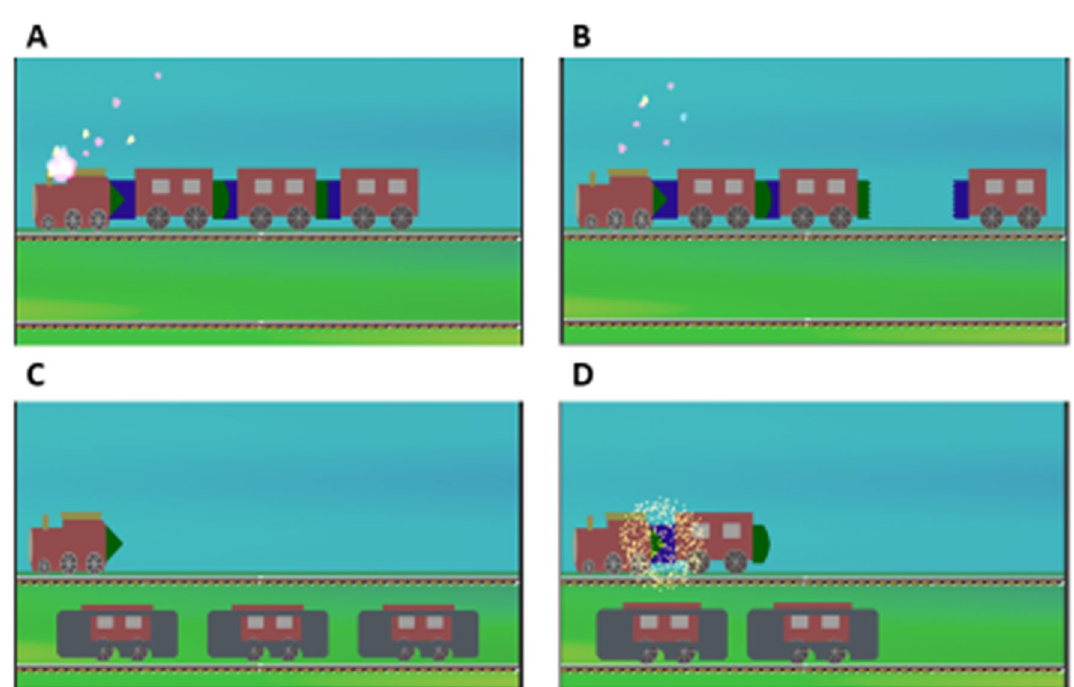
Figure 2. Train game gameplay. ( A ) A train moves into the scene with smoke animation and sound. ( B ) Each wagon detaches from the train and moves to a random position on the rail track below. ( C ) After some delay, the shapes at the ends of the wagons are hidden by a cover. The player is then prompted to select the wagon that has the shape complementary to the last wagon on the train. ( D ) Selection of the correct wagon results in elongation of the train and is rewarded by an audio-visual